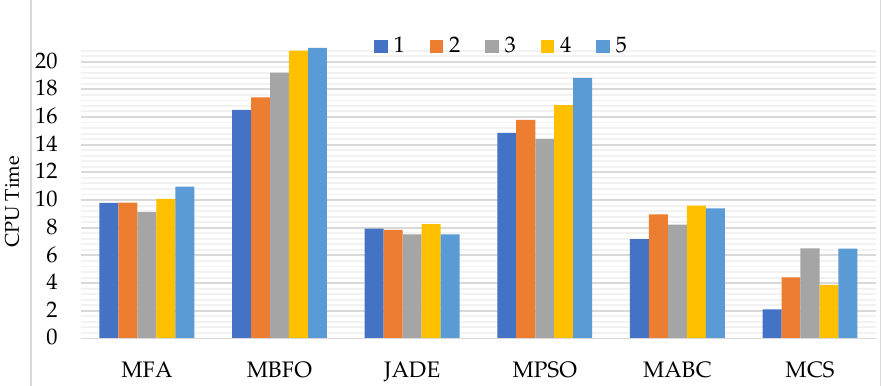
Figure 14. CPU time using different optimization algorithms with Rényi’s entropy.